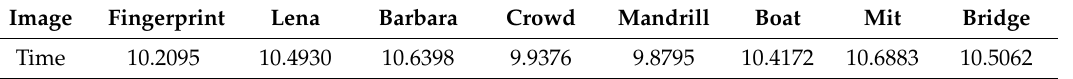
Table 2. Computational time of the proposed method with different image (unit: s).